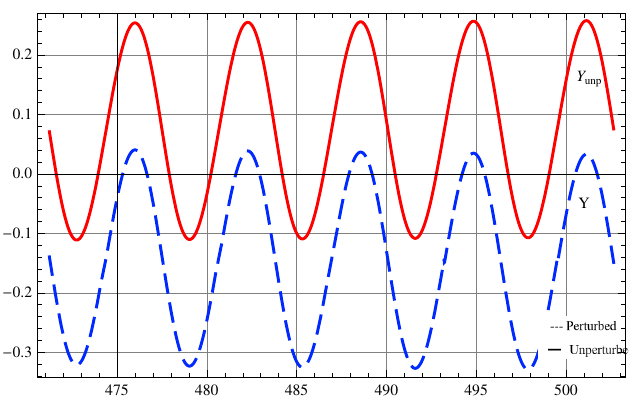
Fig. 3 Perturbed and unperturbed y-component of the deputy relative position vs. Chief true